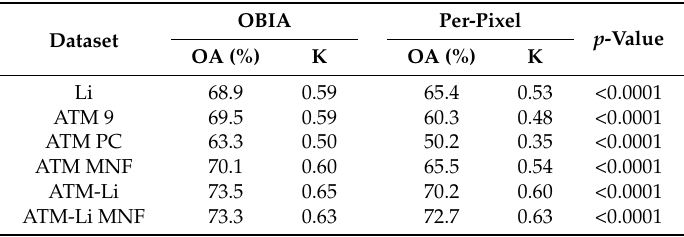
Table 4. Comparison of overall accuracies (OA), Kappa coefficients (K) and statistical significance of differences ( p -value) between the OBIA and per-pixel